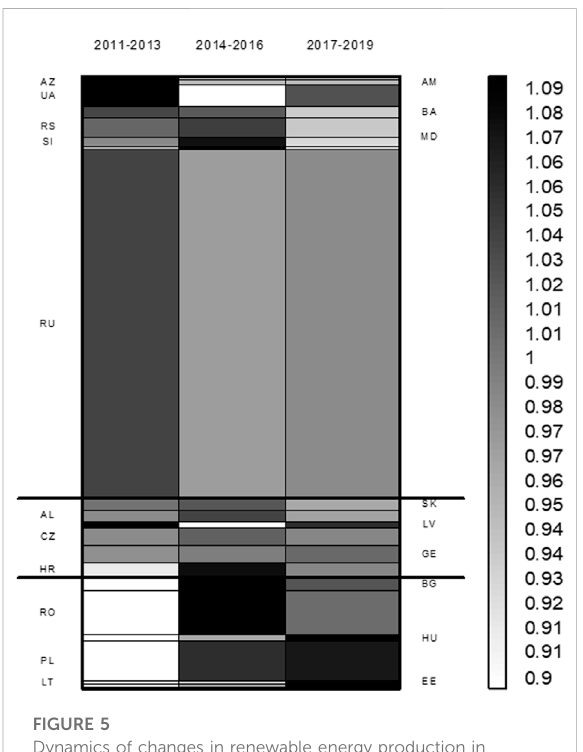
FIGURE 6 Dynamics of changes in renewable energy production per capita in countries of Central and Eastern Europe in 2011 –